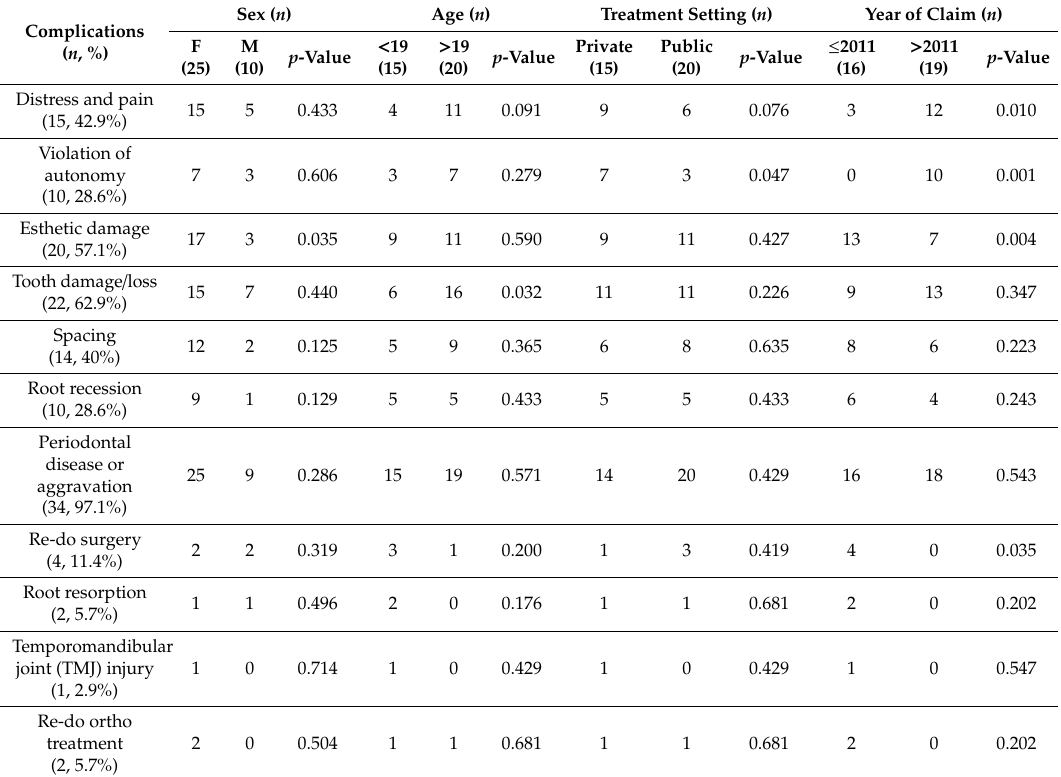
Table 4. Complications divided by gender, age, and treatment settings.